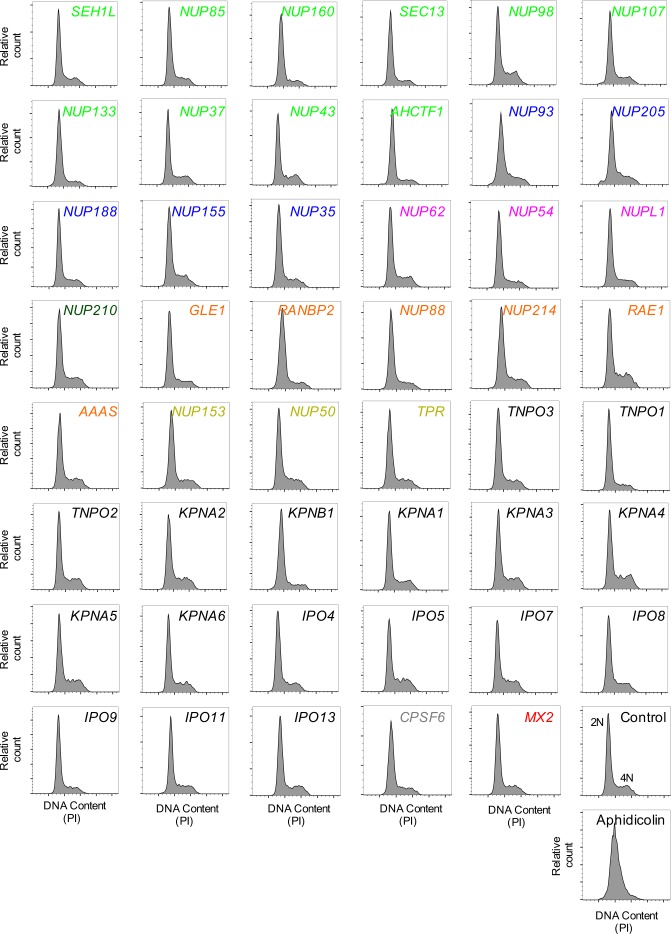
Cell-cycle profile of HeLa cells following transfection with Nup/NTR targeting siRNA.Cell-cycle profile of HeLa cells 64 hr after transfection with the indicated siRNA or following aphidicolin treatment, color coded by subcomplex as in Figure 4A. DNA content was determined by flow cytometry following staining with the DNA dye propidium iodide (PI). For each plot, 3000–12000 events per sample were collected. Representative of two independent experiments. 2N and 4N DNA content are indicated for the Control siRNA transfected sample.